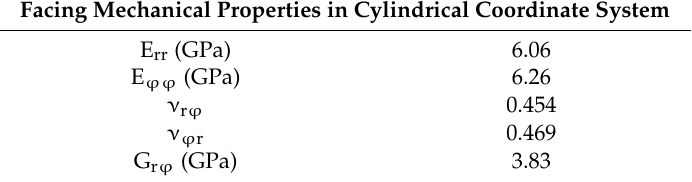
Table 3. Properties of the fiber-reinforced composite in the cylindrical coordinate system. Facing Mechanical Properties in Cylindrical Coordinate System